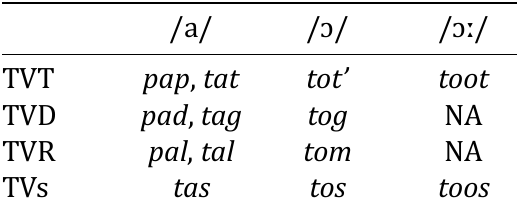
Table A.1: C₁ fortis plosive in monosyllables